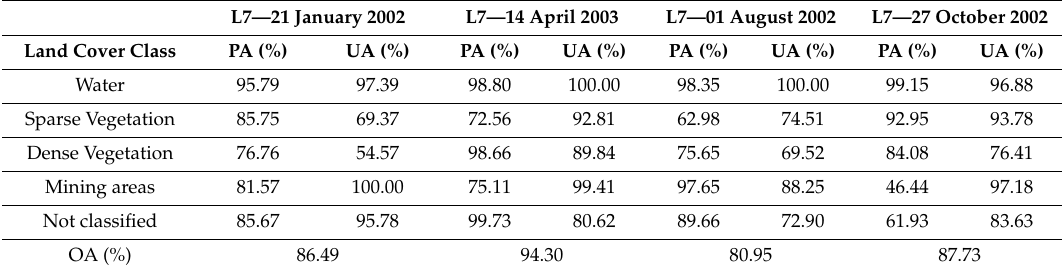
Table 13. OA, PA, and UA obtained computing STRed on the images acquired by Landsat 7 mission. UA, user’s accuracy; PA, producer’s accuracy; OA, overall accuracy.